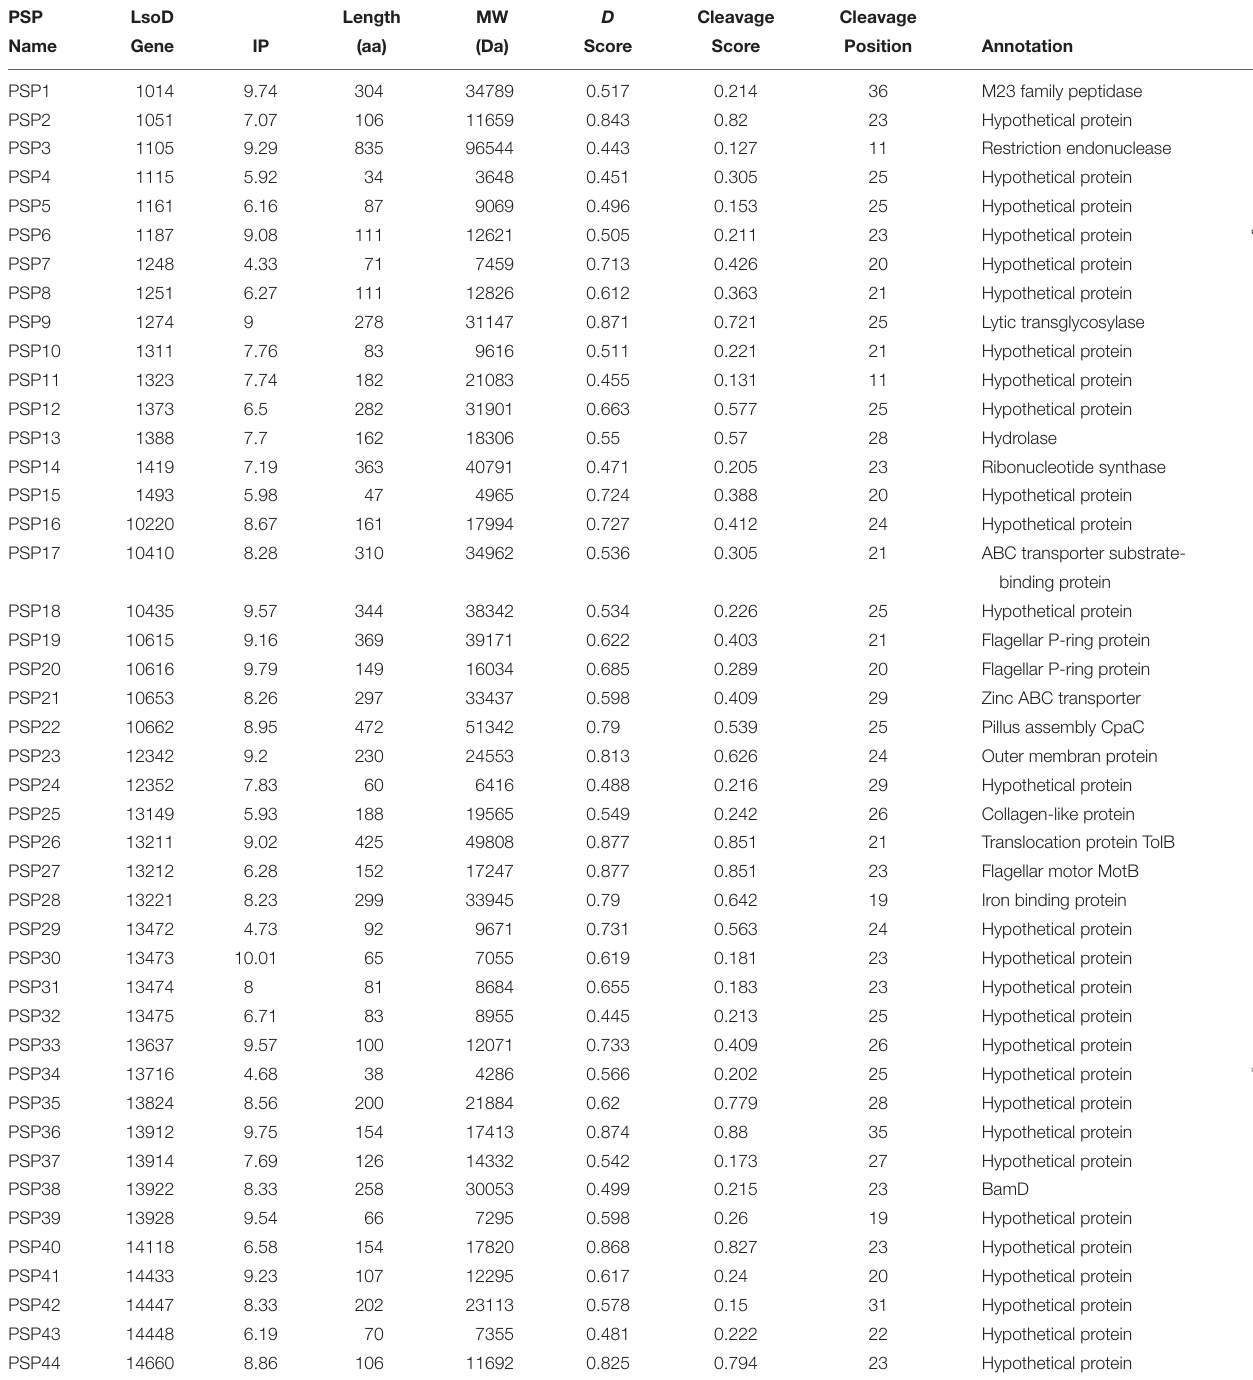
TABLE 3 | Predicted LsoD